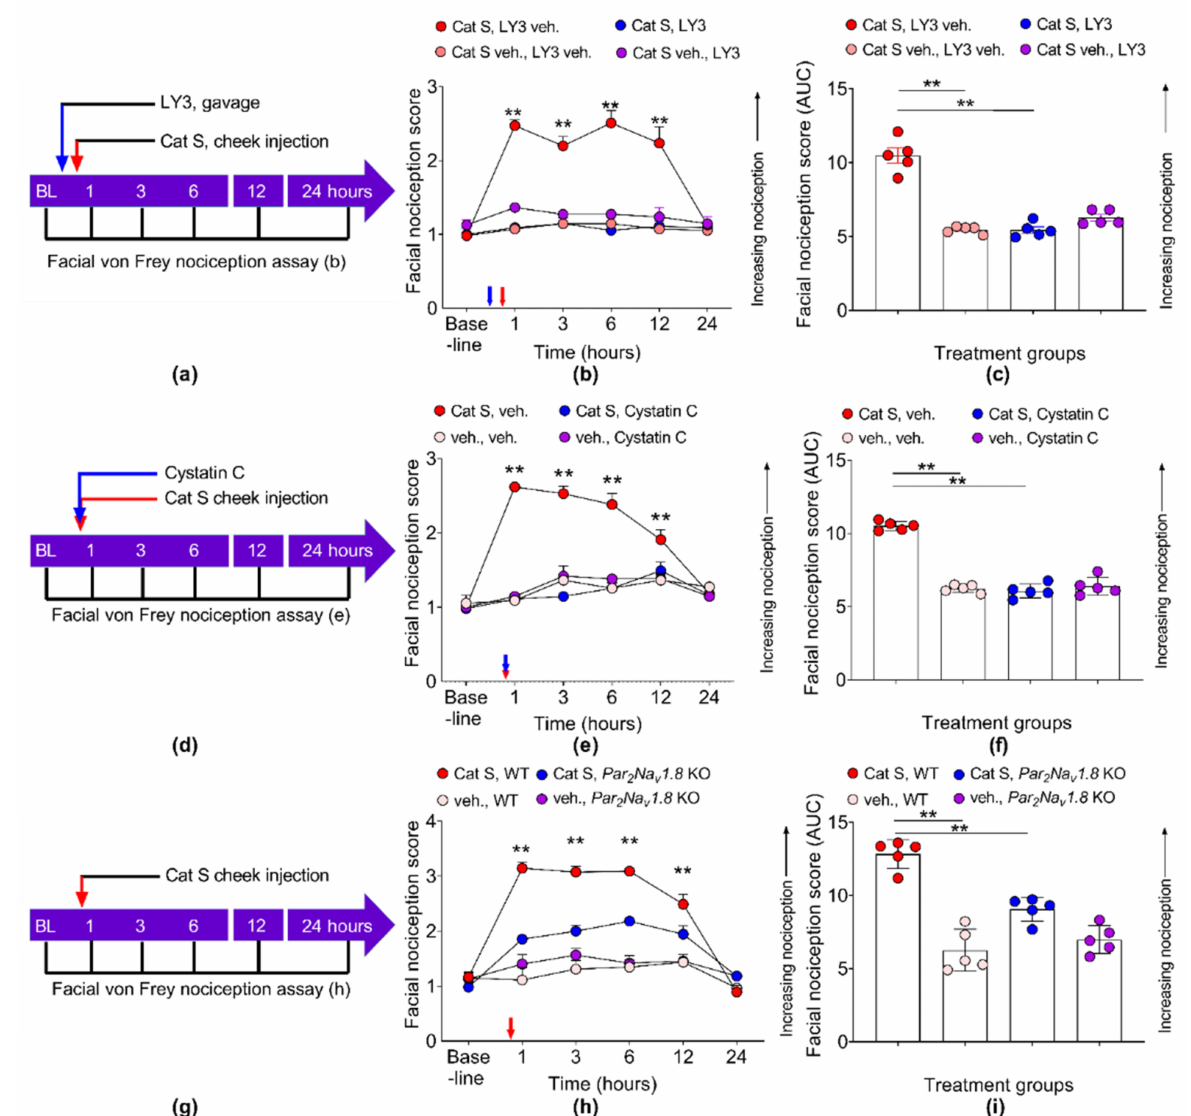
Figure 8. Cathepsin S induces facial nociception through PAR 2 . ( a , d ) Experiment timeline for cathepsin S (red arrow) injection into the left cheek of WT C57BL/6J mice or ( g ) Par 2 Na v 1.8 KO mice. Wild-type mice were treated with ( a ) cathepsin S inhibitor, LY3000328 (LY3) or ( d ) endogenous cathepsin S inhibitor, cystatin C. The facial von Frey nociception assay was conducted before injection (BL or baseline), 1, 3, 6, 12, and 24 h after injection. ( b ) Cathepsin S increased the facial nociception score higher than vehicle injection; the cathepsin S inhibitor LY3 reversed the nociceptive effect of cathepsin S. ** p < 0.01, comparison of cathepsin S, cathepsin S inhibitor vehicle to remaining groups at the indicated time point, two-way ANOVA multiple comparisons. N = 5 mice in each group. ( c ) Area under the curve (AUC) of each individual mouse in ( b ) was plotted. ** p < 0.01, one-way ANOVA. ( e ) Cathepsin S increased the facial nociception score higher than the vehicle; however, cystatin C reversed the nociceptive effect of cathepsin S. ** p < 0.01, comparison of cathepsin S, cystatin C vehicle to remaining groups at indicated time point, two-way ANOVA multiple comparisons. N = 5 mice in each group. ( f ) AUC of each individual mouse in ( e ) was plotted. ** p < 0.01, one-way ANOVA. ( h ) Cathepsin S increased facial nociception score higher than vehicle injection in WT mice, but not in Par 2 Na v 1.8 KO mice. ** p < 0.01 cathepsin S, WT versus cathepsin S, Par 2 Na v 1.8 KO at indicated time points, two-way ANOVA. N = 5 mice in each group. ( i ) The AUC of each individual mouse in ( h ) was plotted. ** p < 0.01, one-way